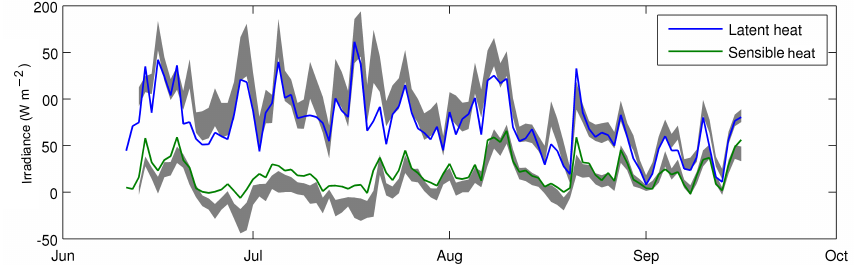
Figure 8. The 5 and 95% uncertainty bounds for the heat fluxes, obtained from the GLUE global sensitivity method. The Nash–Sutcliffe performance was used to evaluate the model for the 2007 open-water